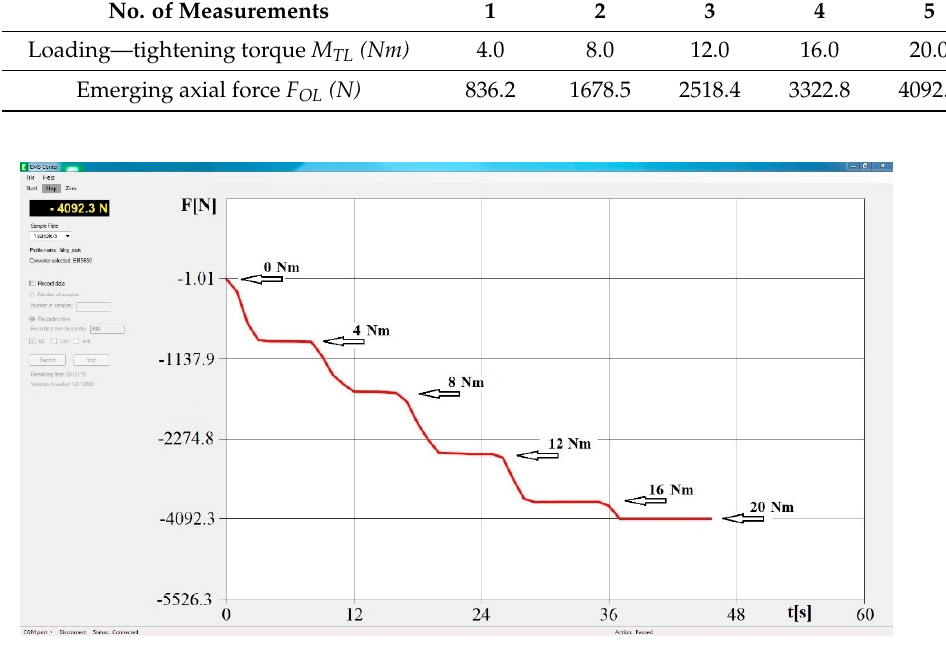
Figure 10. Dependence of the emerging force F OL on time.